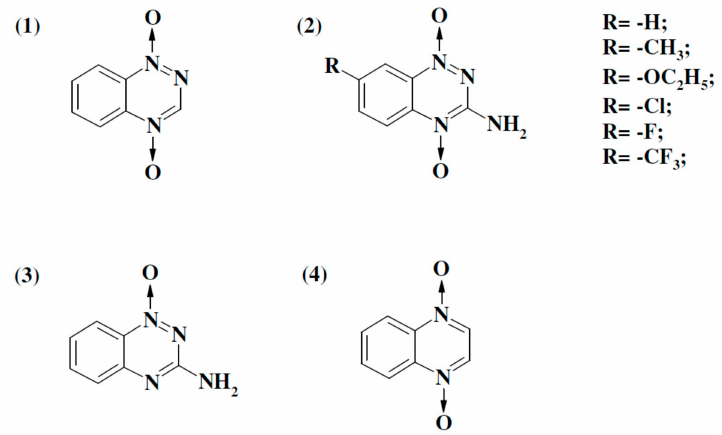
Figure 1. Formulae of aromatic N -oxides used in this work: 1,2,4-benzotriazine-1,4-dioxide ( 1 ), 3-amino-1,2,4-benzotriazine-1,4-dioxide (TPZ) and its derivatives ( 2 ), 3-amino-1,2,4-benzotriazine-1-oxide ( 3 ), and quinoxaline-1,4-dioxide ( 4